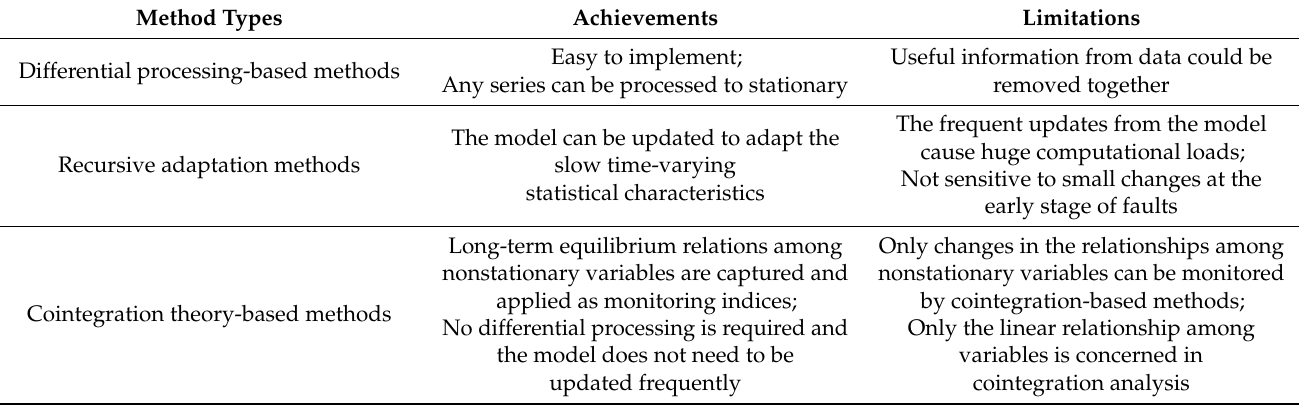
Table 6. Comparative analysis of nonstationary process monitoring